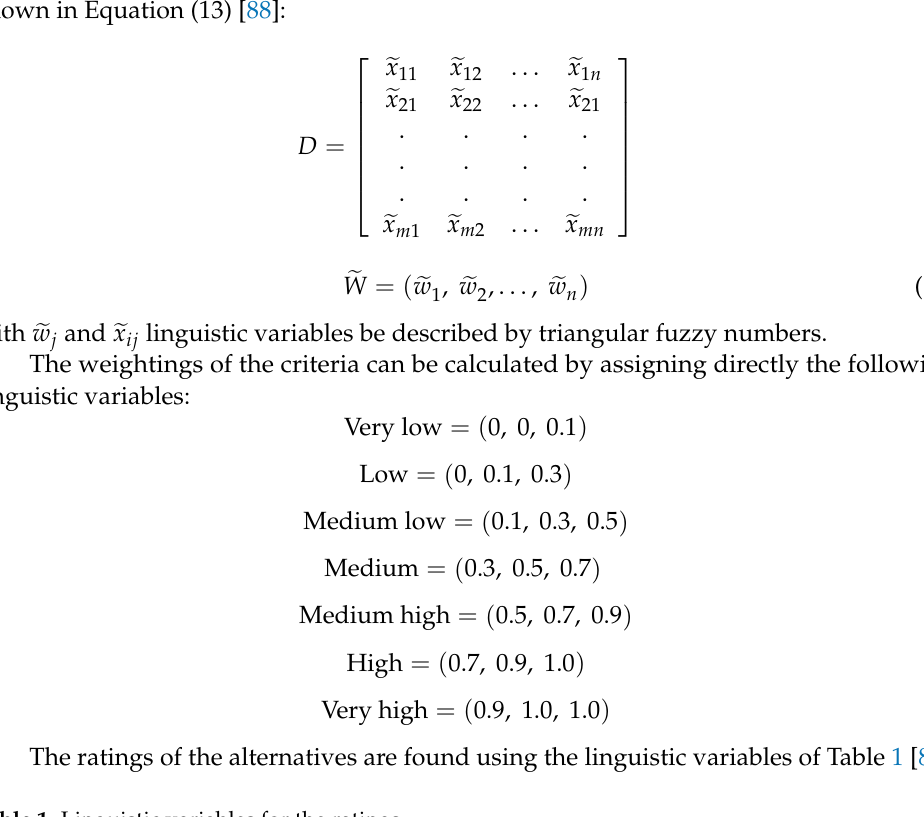
Table 1. Linguistic variables for the ratings. Linguistic Terms for the Ratings